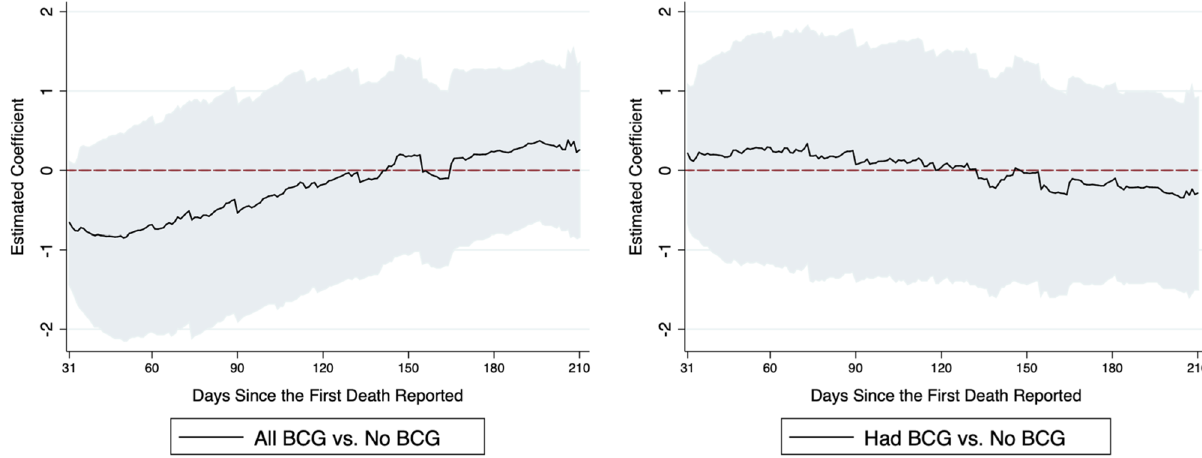
Figure 1. (Model 1): This figure summarizes the estimated effects of all-BCG and had-BCG on cumulative deaths in logarithm since the first death reported. The coefficients are estimated effects of BCG vaccination program for day 31 to day 210, compared to the first 30 days. On the left of the figure are the estimates of α k in Eq. (1), and on the right are the estimates of β k in Eq. (1).